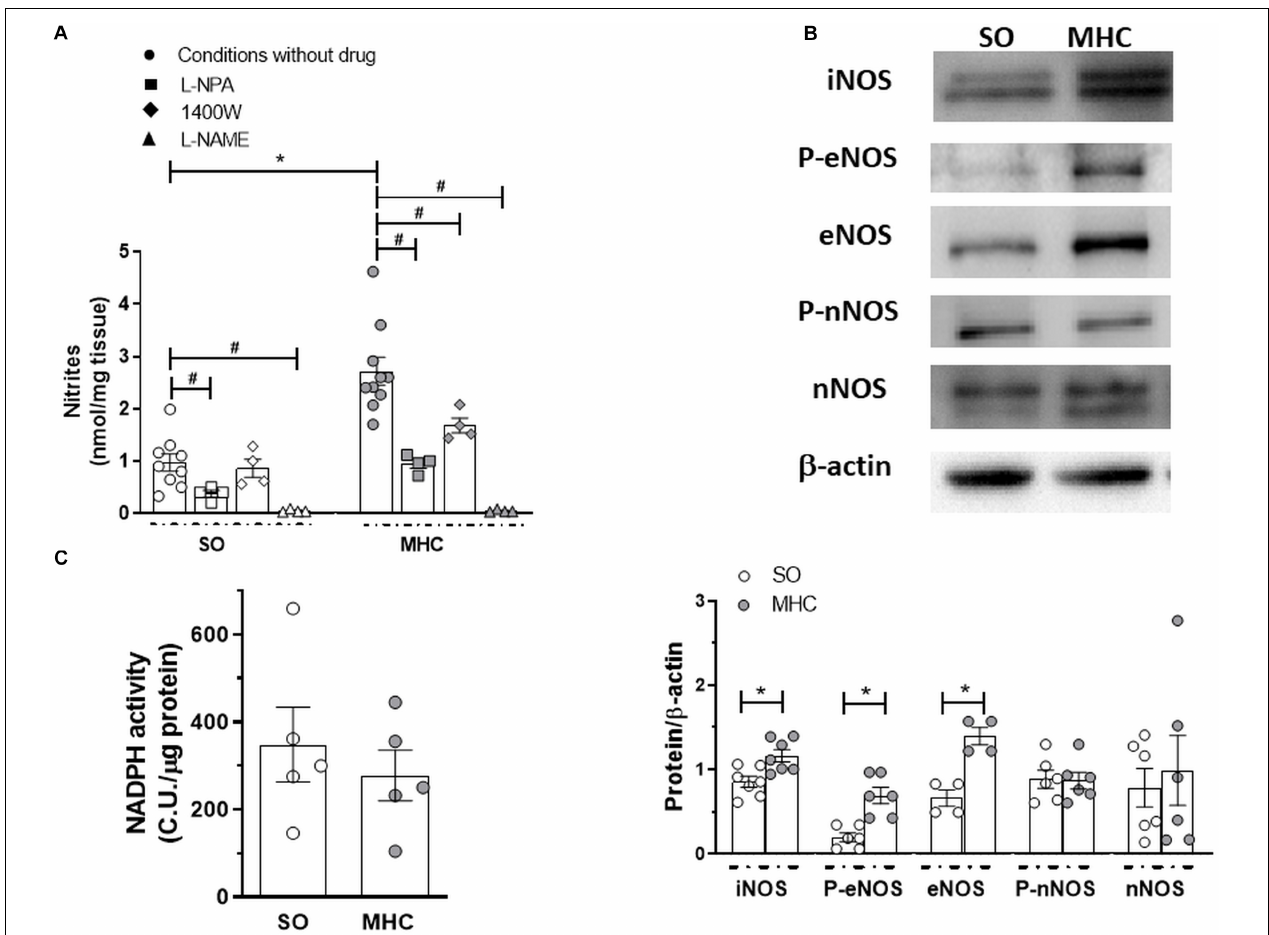
FIGURE 4 | (A) Bradykinin-induced nitrite release in cerebral vasculature from Sham-Operated (SO; n = 4-9 animals) and microsurgical liver cholestasic (MHC; n = 4–10 animals) rats. Effect of preincubation with specific nNOS inhibitor L -NPA, specific iNOS inhibitor 1400W, or non-specific NOS inhibitor L -NAME. Data (Mean ± SEM) were expressed as nmol nitrites/mg tissue. * P < 0.05 SO vs MHC (Student t -test). # P < 0.05 conditions without drug vs. conditiosmn with drug (Student t -test). (B) Western blot analysis for and inducible nitric oxide synthase (iNOS), total and phosphorylated endothelial nitric oxide synthase (eNOS) in the Ser 1177 residue (P-eNOS), and total and phosphorylated neuronal nitric oxide synthase (nNOS) in the Ser 1417 residue (P-nNOS), in cerebral arteries from Sham-Operated (SO) and microsurgical liver cholestasis (MHC) rats. The blots are representative of 4–7 segments from each group. Lower panels show densitometry analysis for the expression of each protein. Results (mean ± SEM) were expressed as the relation between the signal obtained for the protein analyzed and the signal obtained for β -actin. * P < 0.05 SO vs MHC (Student t test). (C) NADPH activity in cerebral vessels from SO and MHC rats ( n = 5 different animals from each group). Results (mean ± SEM) were expressed as chemiluminiscence units (CU.)/ µ g